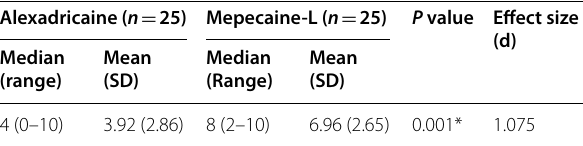
Table 4 Descriptive statistics and results of Mann–Whitney U test for comparison between pain in the two groups according to Wong–Baker facial pain rating scale